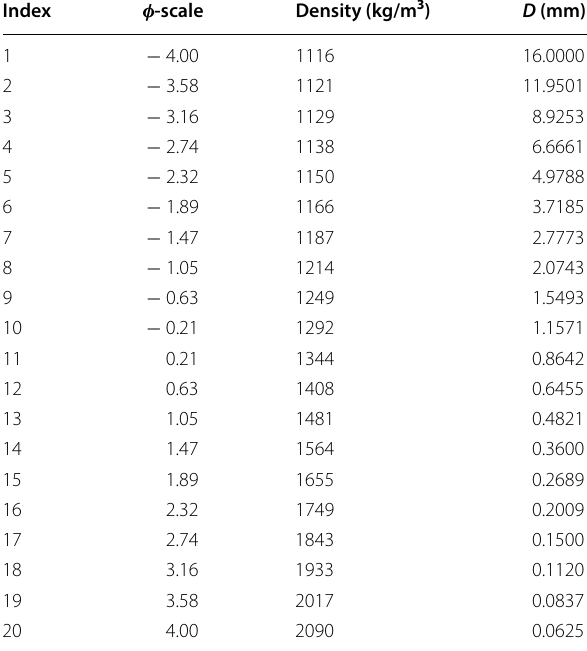
Table 1 List of parameters for classified ash particle